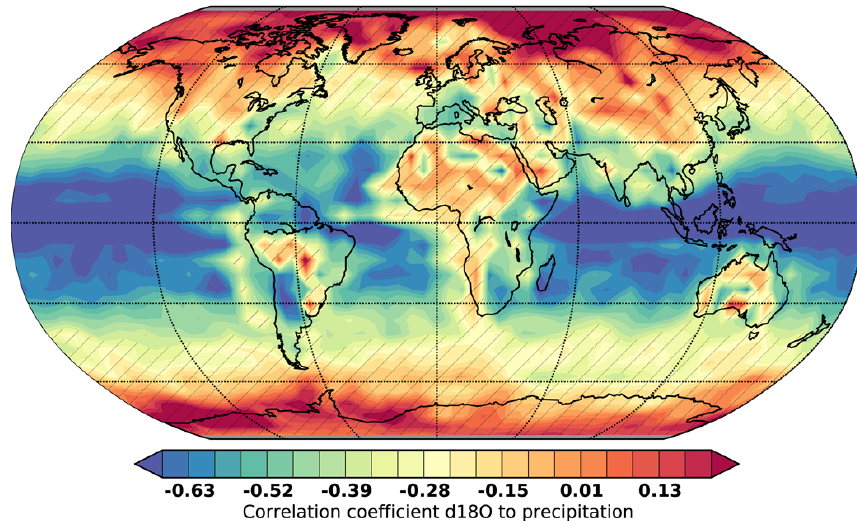
Fig. 6. Spatio-temporal correlation between δ 18 O in precipitation and precipitation rate within i LOVECLIM. Figure is constructed from monthly mean data. Hatching indicates areas where correlation is poor ( < 0.35).